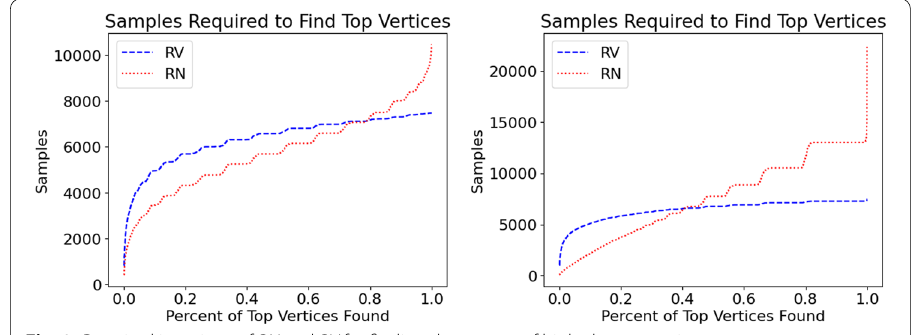
Fig. 2 Required iterations of RN and RV for finding the top x % of high‑degree